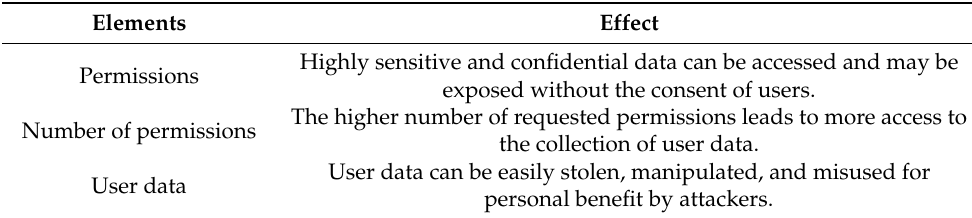
Table 4. Risk-leading elements and their